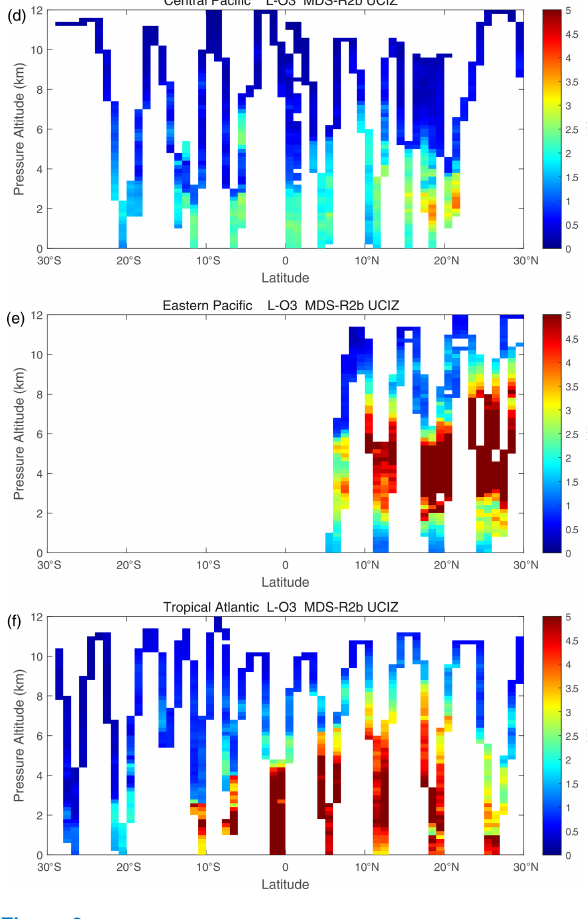
statistics for mid-August used in P2017. The ATom profiles for lightning NO